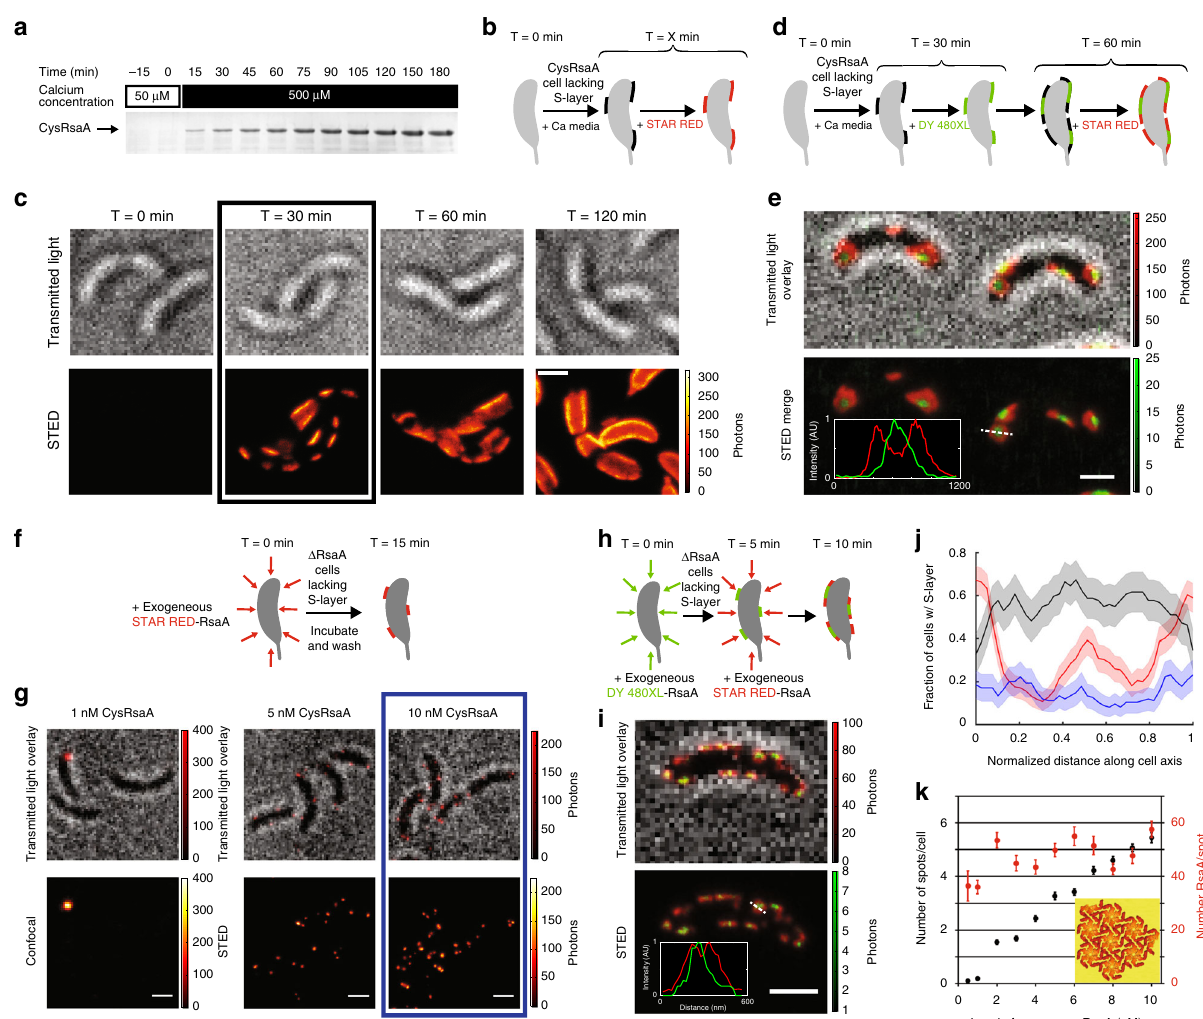
Fig. 3 A new S-layer assembles by crystallization and location depends on crystal size. a Coomassie-stained SDS – PAGE of protein samples extracted from the surface of CysRsaA cells grown in low calcium M2G (50 μ M CaCl 2 , t < 0 min) and then switched to 500 μ M CaCl 2 (0 < t < 180 mins) show de novo accumulation of the S-layer. b Schematic of de novo S-layer assembly experiment where CysRsaA cells are resuspended in M2G with 500 μ M CaCl 2 and then their S-layer is labeled with STAR RED. c A STED imaging time course of STAR RED labeled CysRsaA cells shows that de novo assembly of a new S-layer occurs at discrete patches that grow larger over time. d Schematic of 2-color pulse-chase labeling between 30 and 60 minutes after calcium addition. e STED imaging reveals growth of S-layer patches from their perimeter (red signal at the edges of green patch) and is con fi rmed by line pro fi les of the dashed line (inset). f Schematic of experiment where low concentrations of STAR RED-labeled CysRsaA are incubated with Δ RsaA cells for 15 mins. g STED images show exogenous CysRsaA nucleates small puncta of S-layer. h Schematic of 2-color stepwise addition of 5 nM DY-480XL labeled CysRsaA followed by 10 nM STAR RED labeled CysRsaA. i STED imaging shows that puncta on the cell surface formed by exogenous addition of puri fi ed CysRsaA grow from their perimeter, con fi rmed by line pro fi les of the dashed line (inset). j Quantitation of S-layer assembly localization for native S-layer assembly (red), de novo native S-layer assembly (black), and S-layer assembly by exogenous addition of labeled CysRsaA (blue). Shaded regions show 95% con fi dence intervals for n = 100, 50, and 65 cells for native, de novo, and exogenous protein addition, respectively. k Quantitation of the number of S-layer puncta and average number of RsaA molecules per punctum on Δ RsaA cells upon addition of puri fi ed CysRsaA protein. Error bars represent SEM. A model of an RsaA crystal of about the measured size is shown (inset). Scale bars = 1 μ m ( c , e , g , i